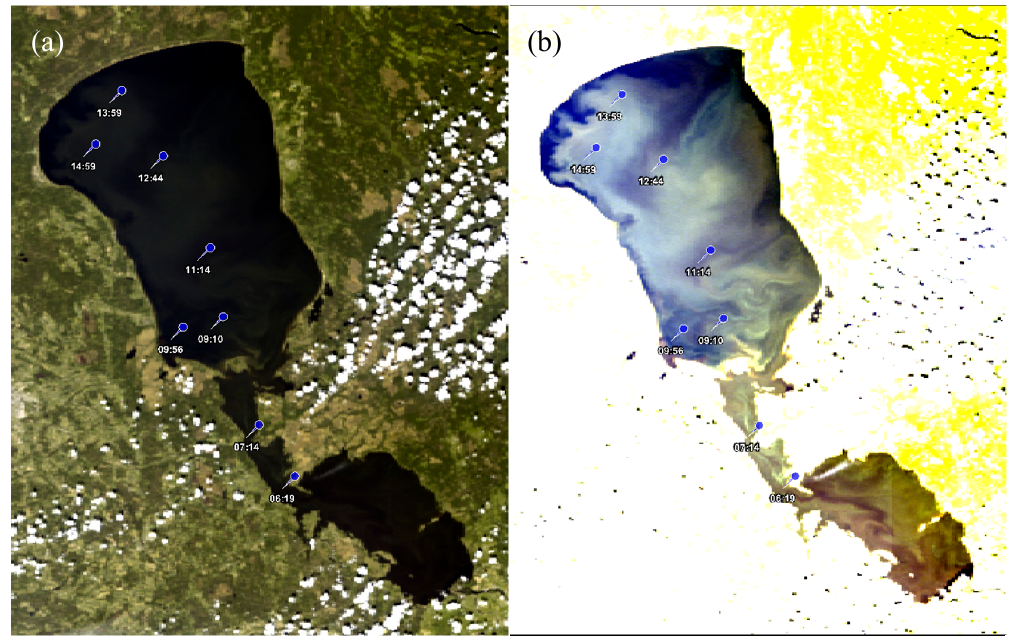
Figure 4. S3A/OLCI L1 image as RGB ( a ) and with modified RGB histogram ( b ) from 14 June 2016 with overpass 8:25 UTC. The in situ sampling stations with measurement time (UTC) on the same day are marked with pins.